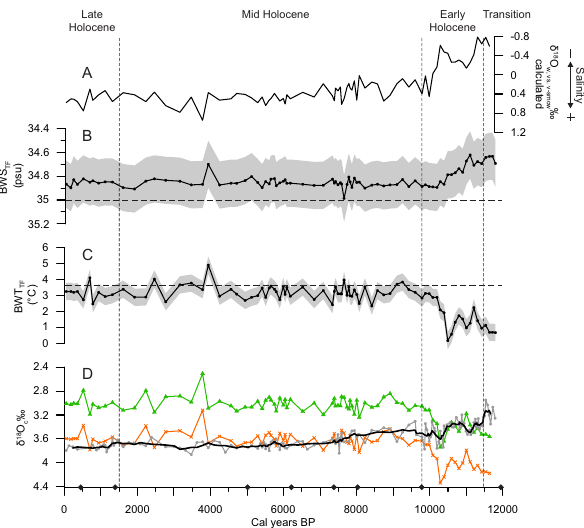
Fig. 5. (A) Calculated δ 18 O w, vs. v-smow . (B) Salinity record as cal- culated by transfer functions (black) with error bar in grey shad- ing. Present-day salinity is indicated by dashed line. (C) Temper- ature record as calculated by transfer functions with error bar in grey shading. Present-day temperature is indicated by dashed line. (D) δ 18 O c record (grey line) with five-point running average (black line) together with calculated δ 18 O c from Kangerdlugssuaq Fjord (green, triangles) and Nordic Seas (orange, asterisks) mixing lines. Black diamonds on x axis indicate calibrated age